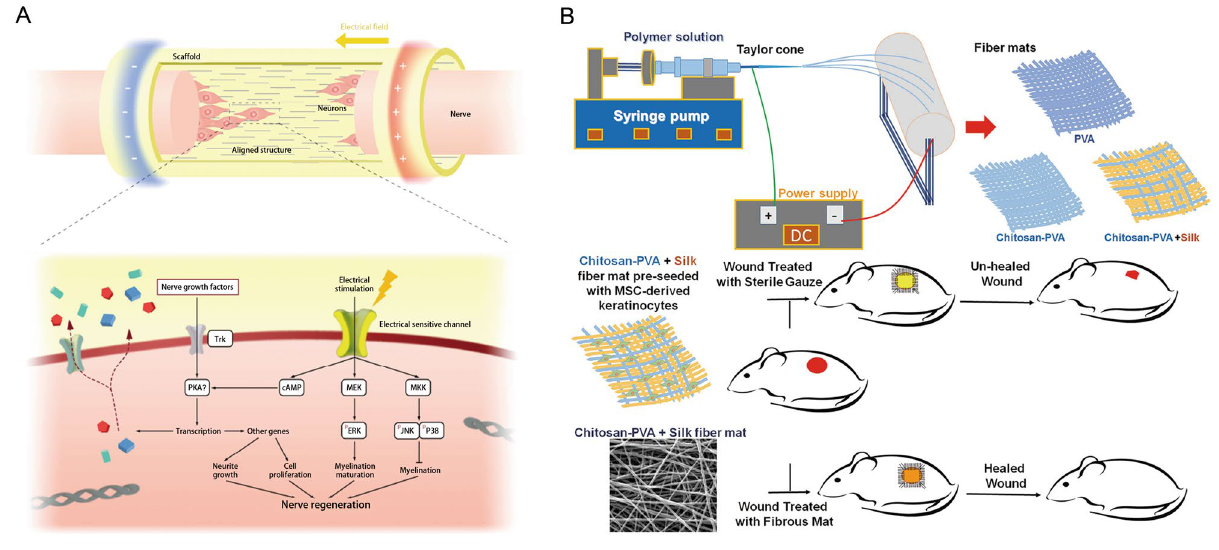
full-thickness wound 6 excision rat model to evaluate the wound healing potential of transplanted CH-PVA + silk mat preimplanta- tion of MSC-derived keratinocytes [89]. Reprint with permission from Springer